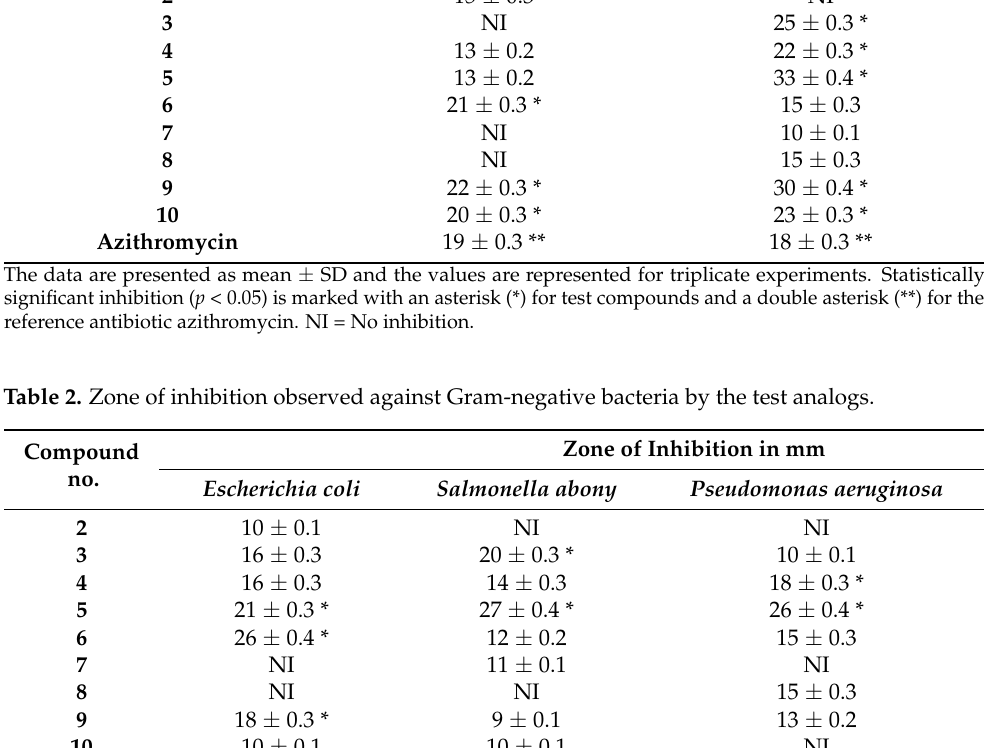
Table 1. Zone of inhibition was observed against Gram-positive bacteria by the test analogs. Compound no.